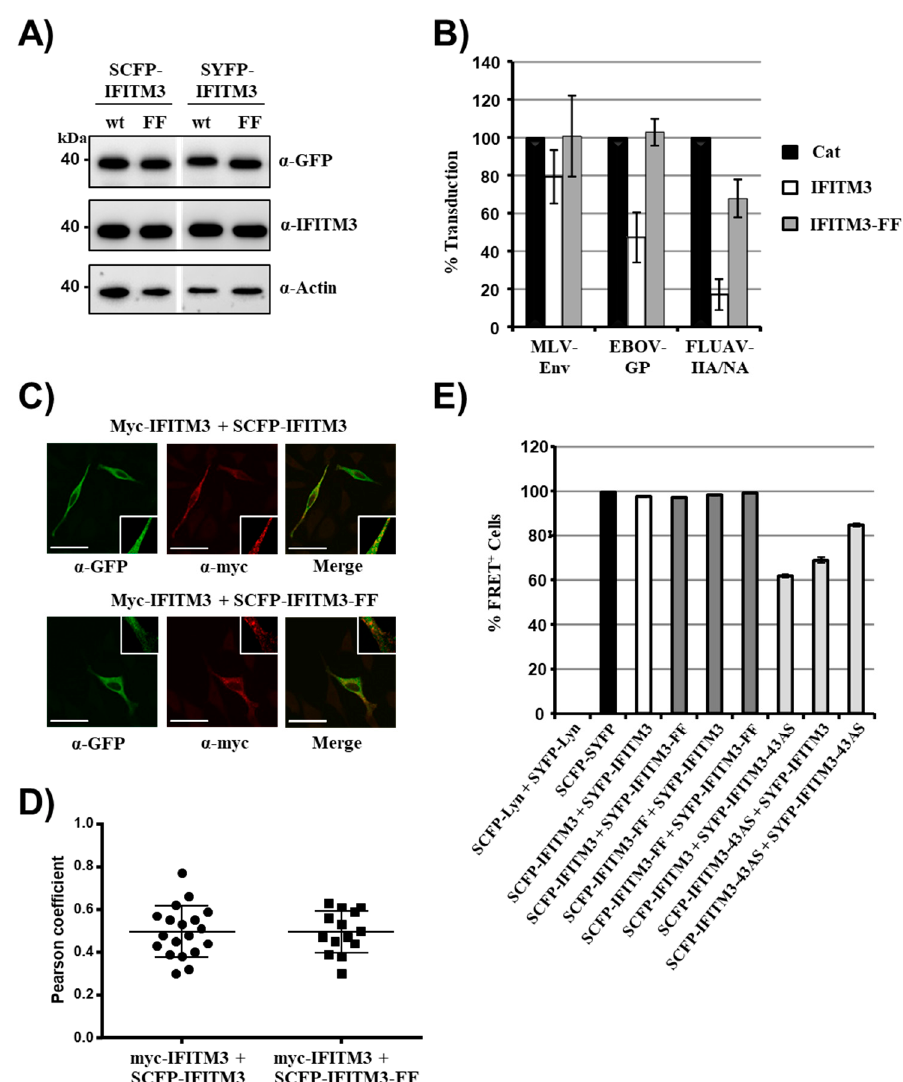
Figure 3. F75 and F78 in IFITM3 are dispensable for colocalization with IFITM3-wt. ( A ) 293T cells were transfected with plasmids encoding the indicated IFITM3 fusion proteins, and protein expression was analyzed by Western blot, employing anti-GFP (upper panel) and anti-IFITM3 (middle panel) antibodies for detection. Staining with anti- β -actin (lower panel) antibody served as negative control. The results of a representative blot from which irrelevant lanes were removed (white space) are shown. Similar results were obtained in two separate experiments. ( B ) 293T cells were transduced with vectors encoding IFITM3-wt, IFITM3-FF (both without antigenic tag) or Cat as control. Subsequently, the cells were transduced with infectivity normalized MLV vectors encoding firefly luciferase and pseudotyped with the indicated viral glycoproteins. At 72 h post transduction, the luciferase activities in cell lysates were determined. The average of three to four independent experiments, each carried out with triplicate samples, is shown. Error bars indicate standard error of the mean (SEM). ( C ) To analyze protein localization, HeLa cells were transfected with the indicated plasmids, stained with anti-GFP (green channel) or anti-myc (red channel) antibodies and analyzed by confocal microscopy. Scale bars indicate 50 µ m. Areas of colocalization are magnified in the white squares (19.3 × 19.3 µ m). ( D ) Pearson correlation coe ffi cient analysis of the confocal images taken in panel C. ( E ) FRET analysis of 293T cells transfected with the indicated plasmid combinations at 48 h post transfection. Shown are the results of a representative experiment performed with triplicate samples, error bars indicate SD. Similar results were obtained in a separate experiment. See Supplementary Figure S4 for representative primary FRET / CFP